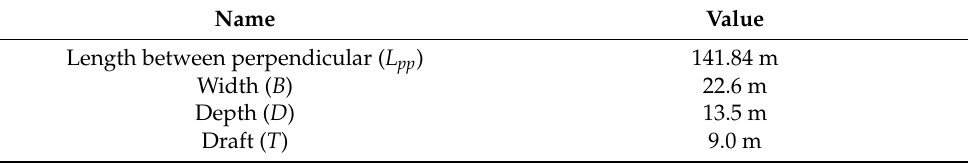
Figure 2. Ship model of traditional icebreaker bow. ( a ) Front view, ( b ) Top view and side view. Table 3. Ship parameters of traditional icebreaker bow.